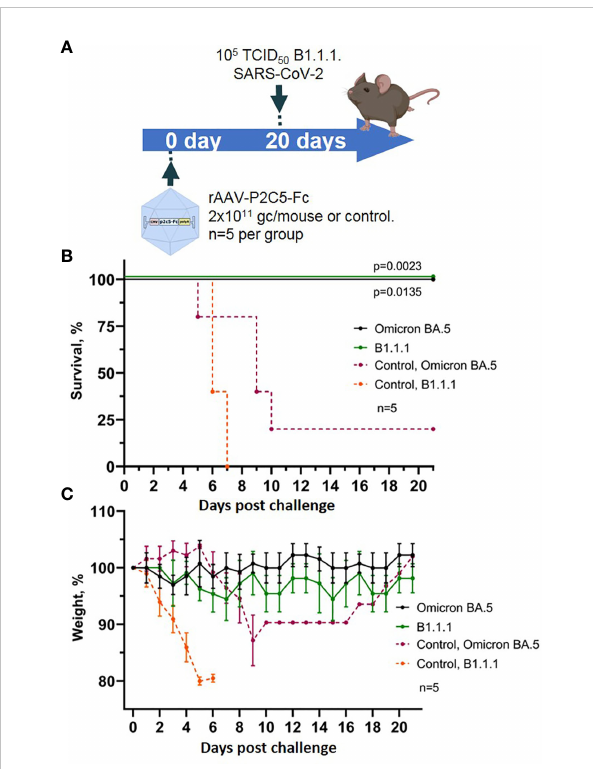
FIGURE 6 Evaluation of rAAV-P2C5-Fc protective capacities against